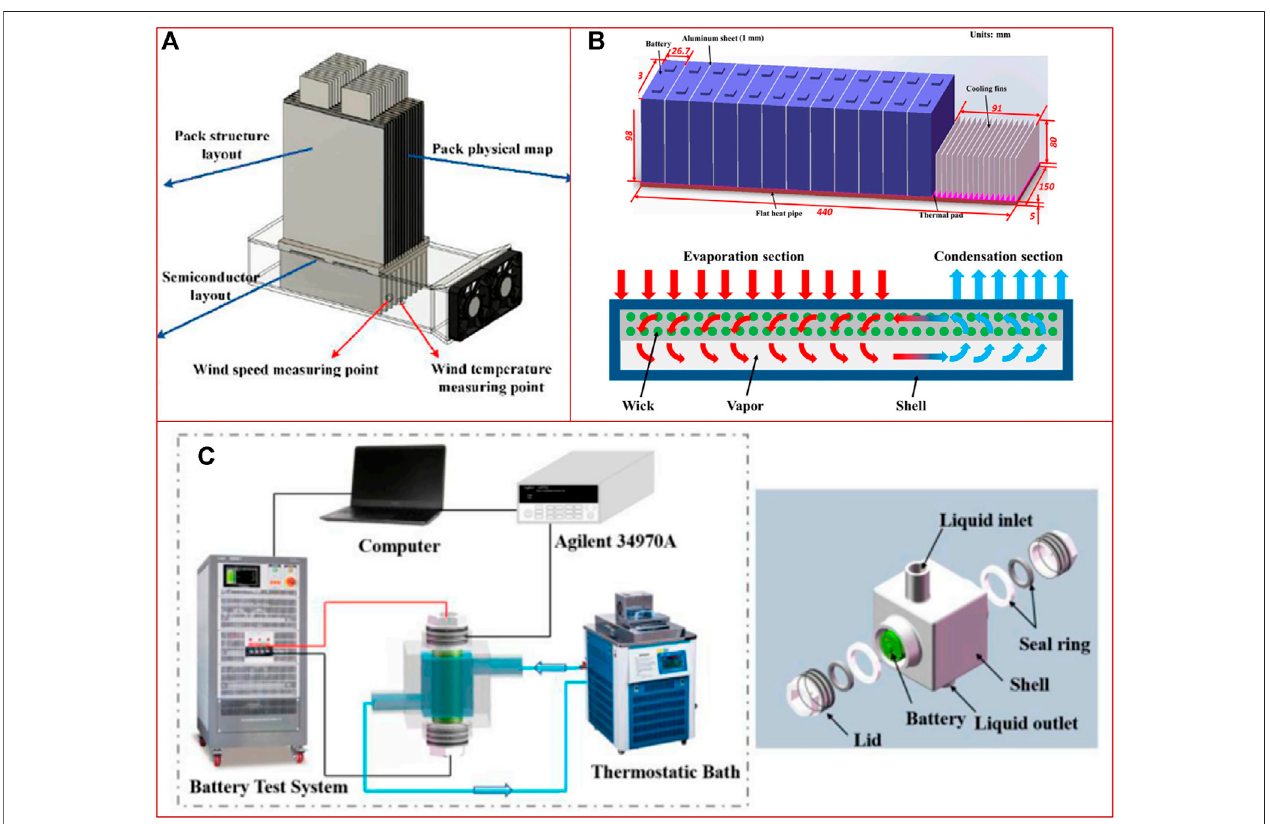
FIGURE 1 | Illustrations of a BTMS structure. (A) A semiconductor and air cooling by Yang et al.; (B) A fl at heat pipe and air cooling by Wang et al.; (C) Immersion water cooling by Luo et